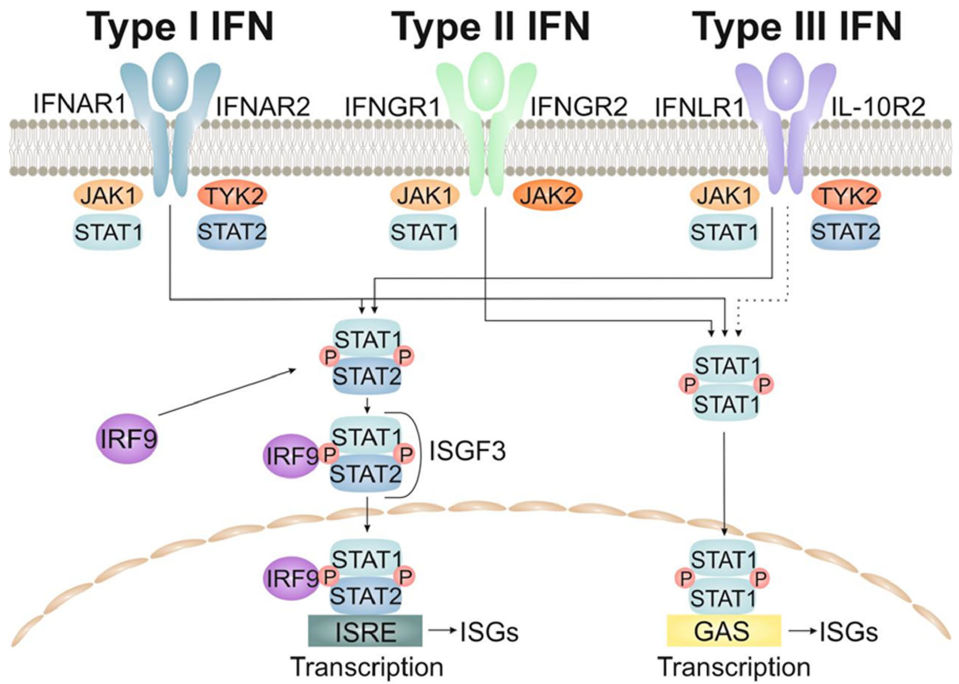
Figure 1. Interferon signaling pathways to the cell nucleus.